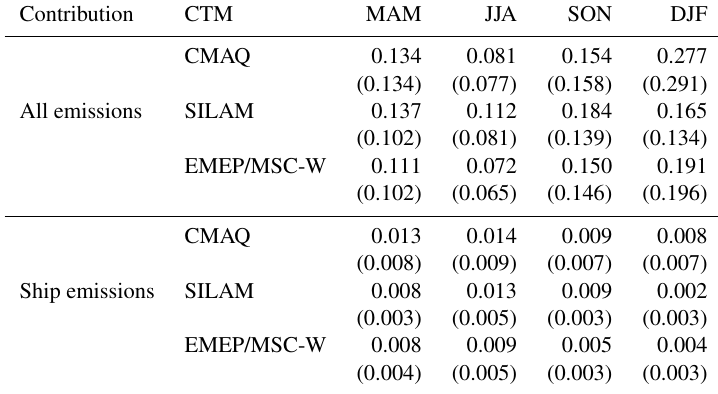
Table 4. Spatial averages of seasonal mean concentrations of EC (µgm − 3 ) from the base simulation and ship contributions to EC levels (µgm − 3 ) for the study domain (Baltic Sea region as in Fig. 1). Mean values are given for spring (March to May; MAM), summer (JJA), autumn (September to November; SON) and winter (January, February and December 2012; DJF). Values in brackets denote the seasonal mean concentrations in the coastal land areas of the